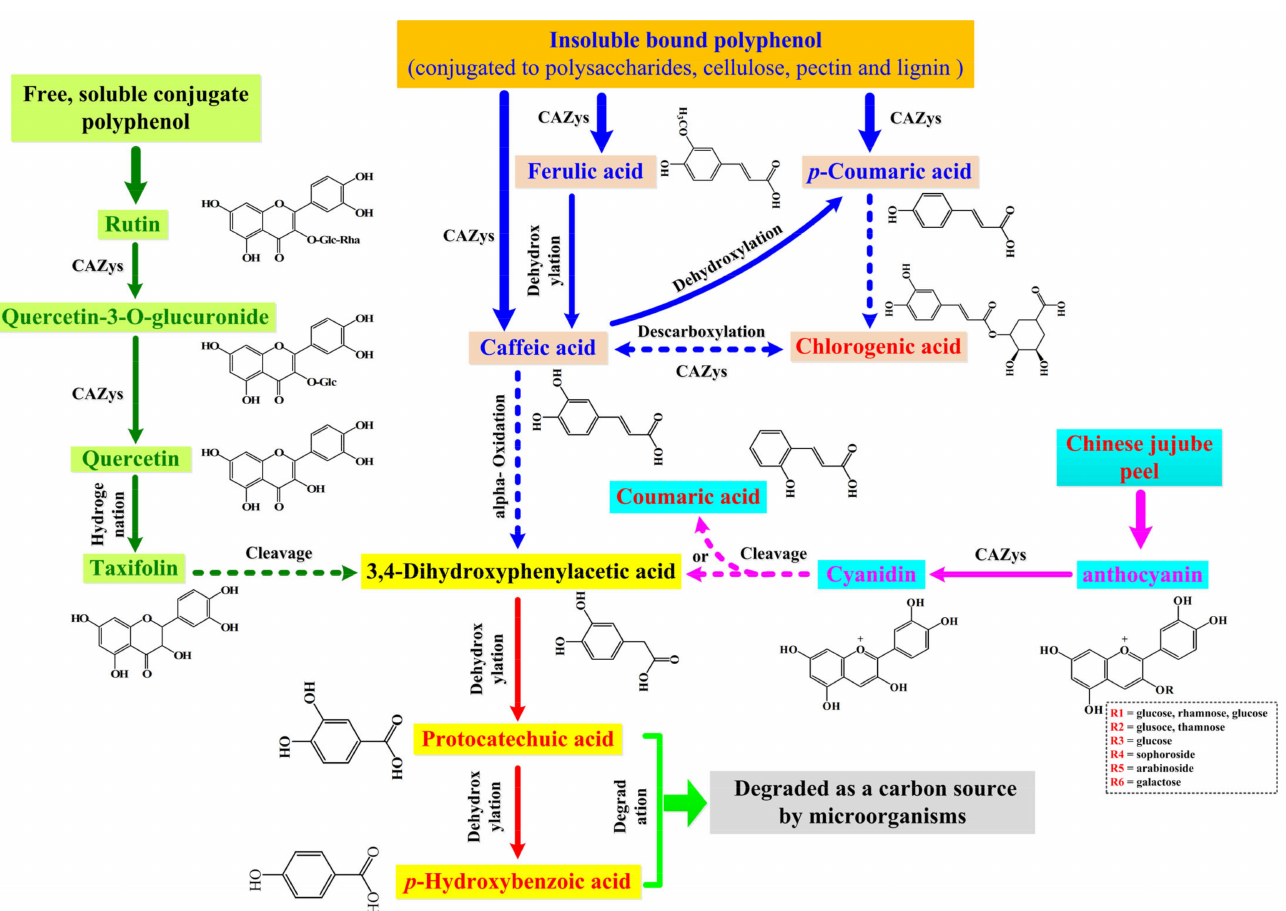
Figure 6. Proposed catabolic pathways of polyphenols degradation and transformation in the fermented Chinese jujube by M. purpureus . The solid and dotted arrows represented the one-step and multi-step reactions,